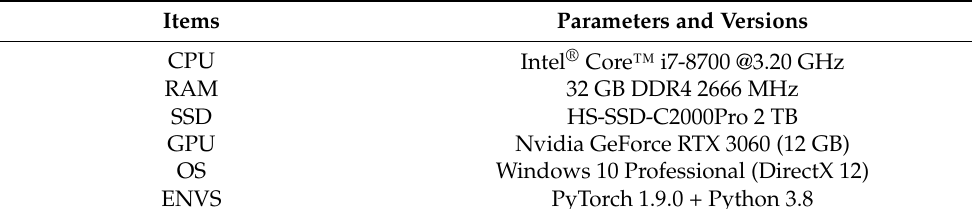
Table 1. Parameters of the software and hardware.